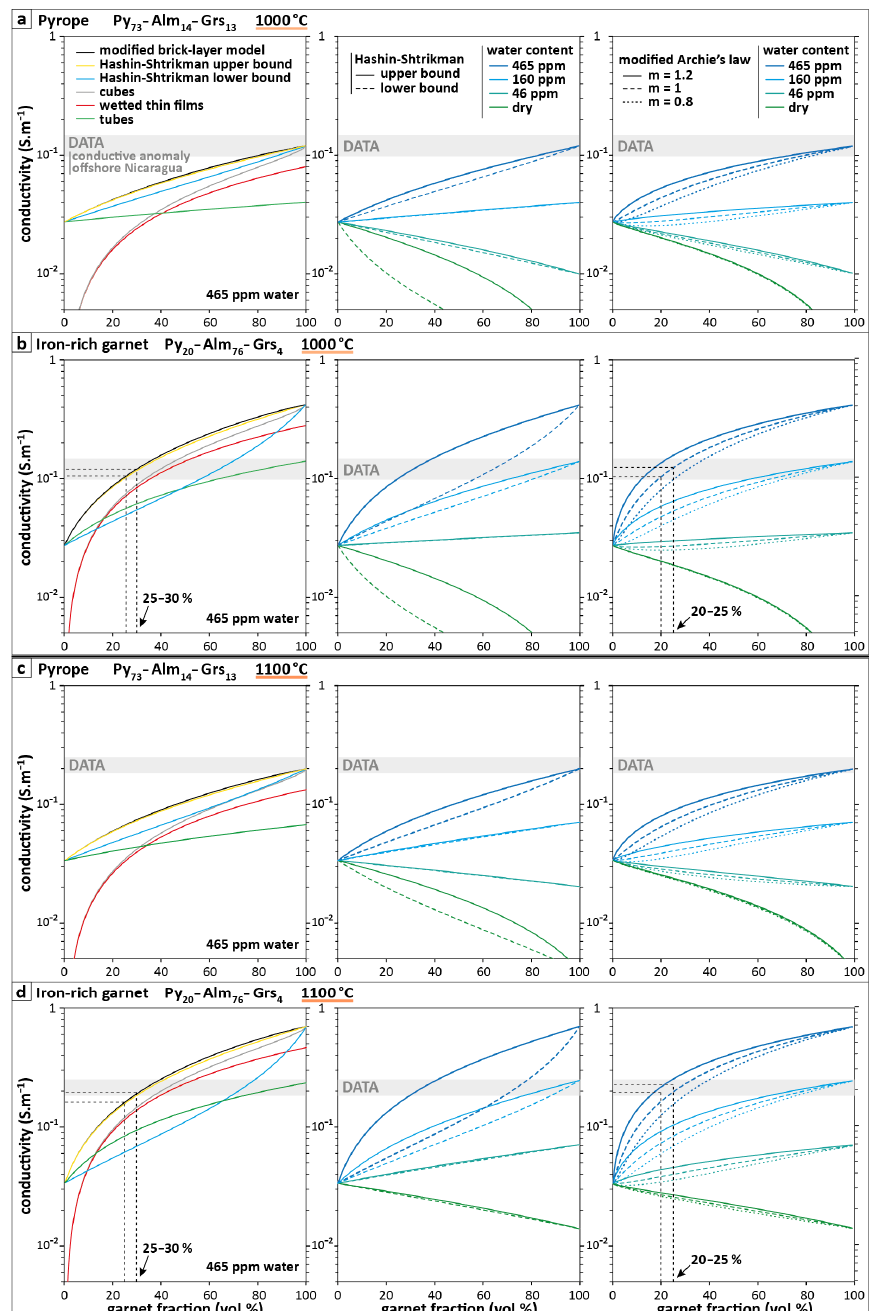
Figure 7. Numerical simulations of electrical conductivity for various amounts of garnet. Physical models illustrated in Figure 6 and additional modeling with a modified Archie’s law [54] (implicit geometrical factors). The formulas are described in Table 1. The simulations are performed for a pyroxenite at 2 GPa ( ≈ 60 km) containing ( a ) natural pyrope at 1000 ◦ C, ( b ) iron-rich garnet at 1000 ◦ C, ( c ) natural pyrope at 1100 ◦ C and ( d ) iron-rich garnet at 1100 ◦ C. In each case, three subfigures are presented, showing simulation results for the di ff erent models (left), for the Hashin–Shtrikman upper and lower bounds (center) and the modified Archie’s law (right). The gray shade indicates the data (conductive anomaly recorded using MT o ff shore Nicaragua) [3]. The high impact of water content is illustrated for the Hashin–Shtrikman geometry and Archie’s law. The impact of water defects on the conductivity of olivine and pyroxenes (values and references in Figure 5) is taken into account (except for the “wetted thin films” and “cubes” models, too simplified if both the conductive network and the less conductive part of the rock are somehow